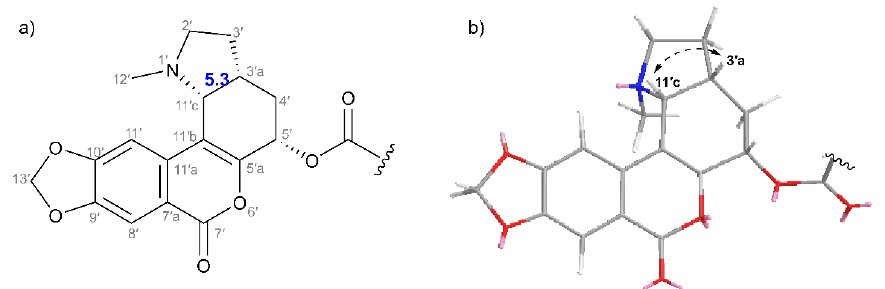
Figure 5. Determined relative configuration of unit B ( 3 ). ( a ) H- 3′a/H - 11′c value of J -coupling (given in Hz) determined the cis -orientation. ( b ) Stick presentation of unit B with NOESY correlation shown by dashed arrow.